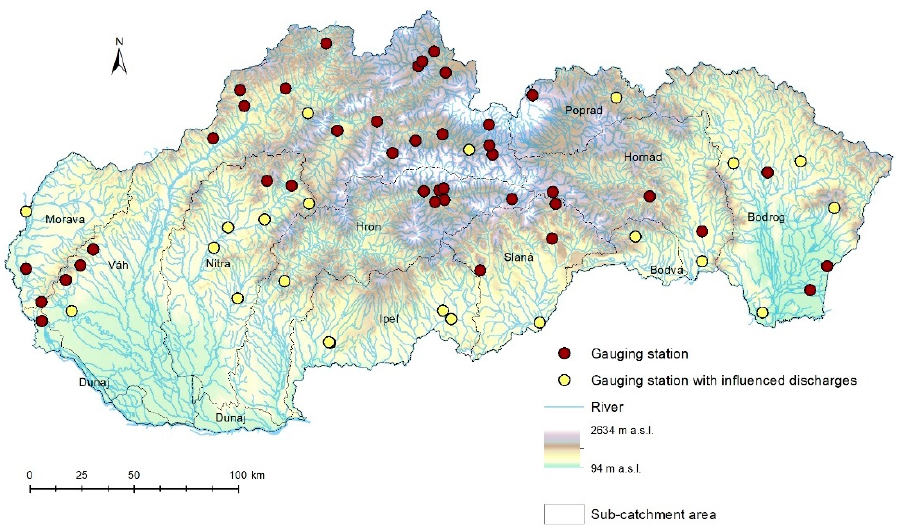
Figure 1. Location of the selected water-gauging stations. For the selected stations, we evaluated the low-flow characteristics and their changes between the 2001–2015 and 1961–2000